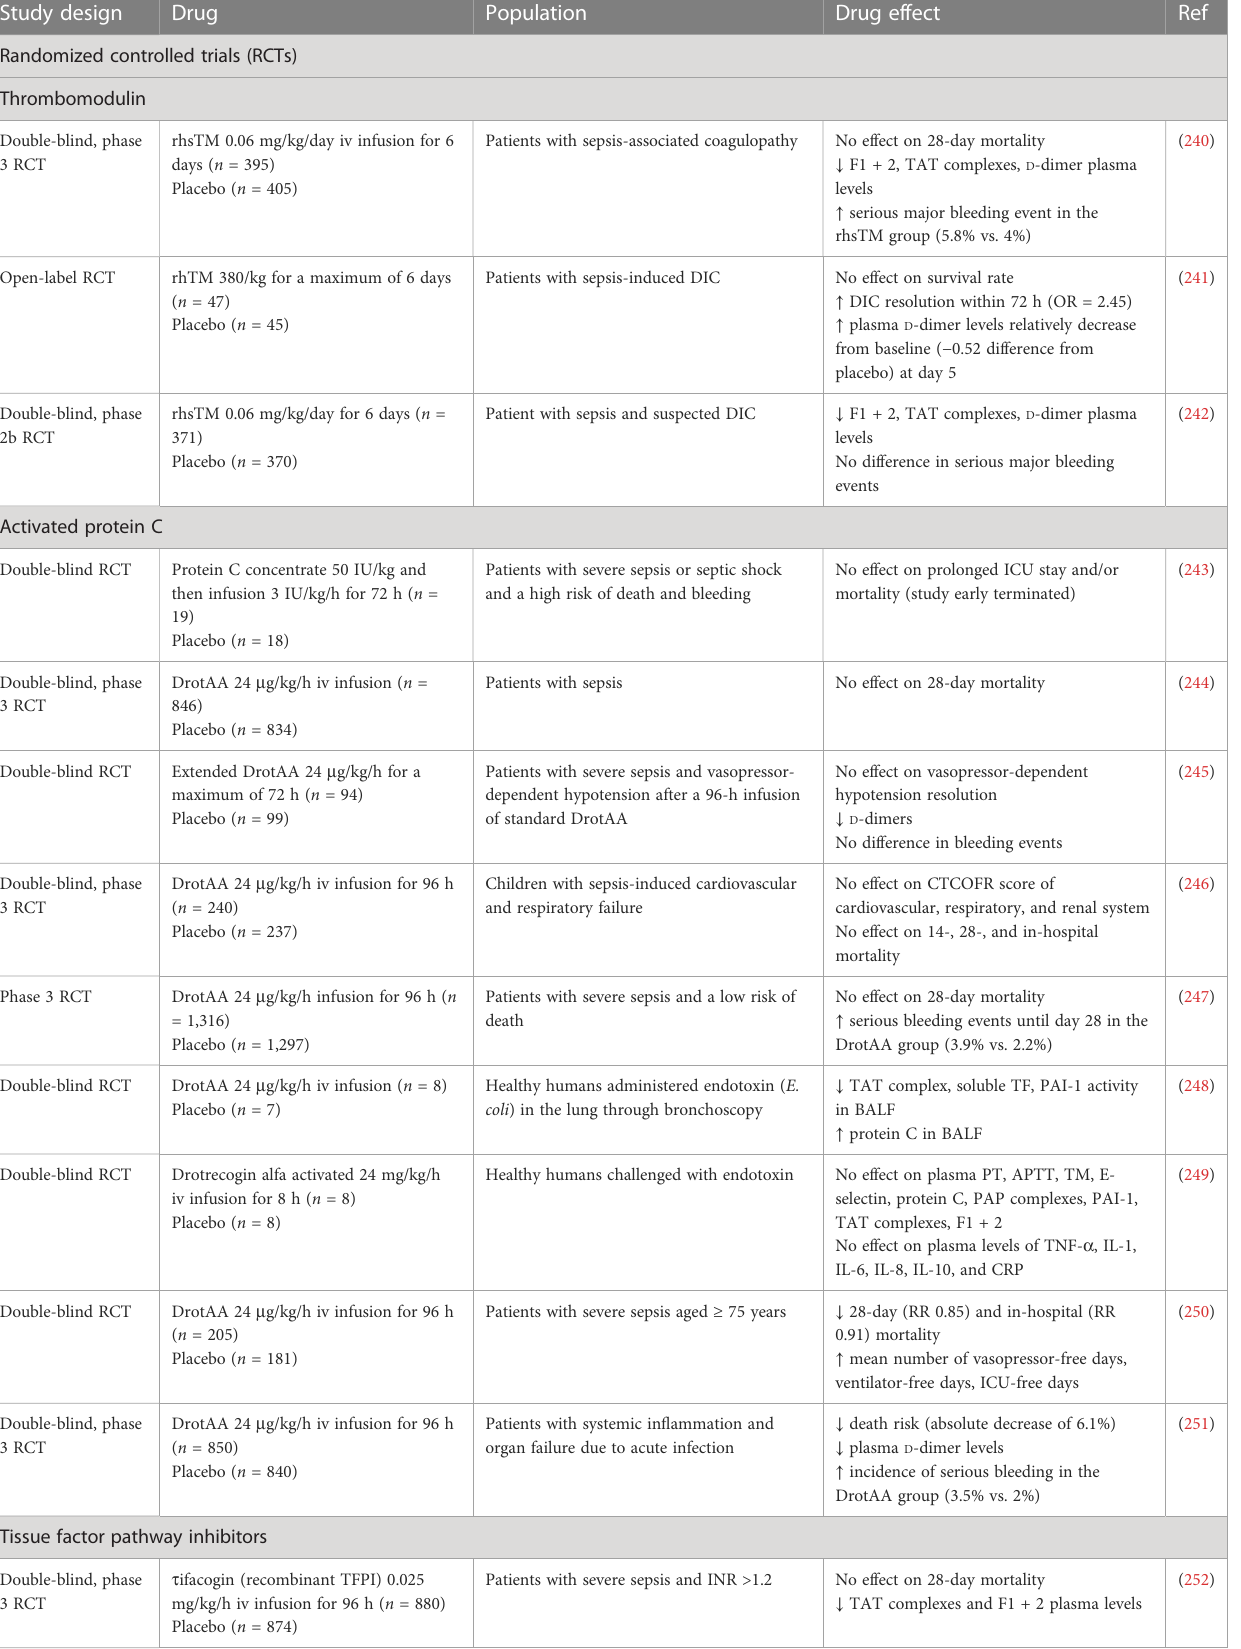
TABLE 7 Clinical evidence on drugs targeting immunothrombosis in